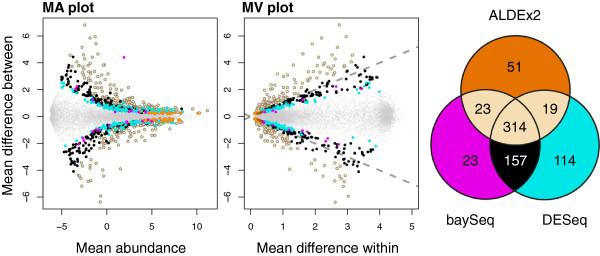
Differential features in common between ALDEx2, DESeq and baySeq. Genes are colored in light yellow if ALDEx and at least one of the other two tools identified them as significantly different with an fdr <0.05, black if they were identified by both baySeq and DESeq, magenta if only by baySeq, cyan if only by DESeq, and orange if only by ALDEx2. Small gray dots are non-differential genes. The Venn diagram illustrates the number of differentially abundant genes identified by each method. MA, mean difference between conditions vs average expression; MW, mean difference between conditions vs maximum within-condition variance.